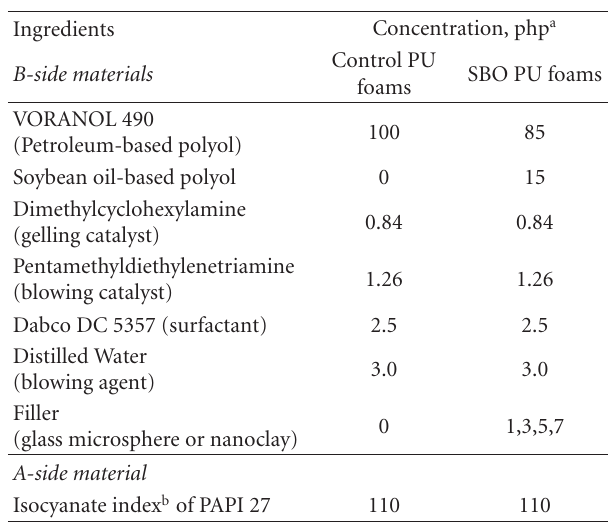
Table 1: Foaming formulation of rigid soybean oil-based poly- urethane foams (SBO PU foams) modified with fillers.